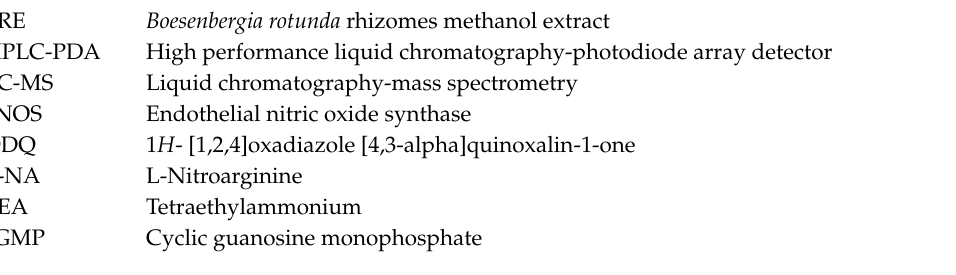
Figure S1. Comparison of HPLC profiles for three fractions derived from the vasoactive MeOH extract of Boesenbergia rotunda rhizomes (BRE), Figure S2. 1 H and 13 C NMR data of naringenin 5-methyl ether ( 1 ), Figure S3. 1 H and 13 C NMR data of alpinetin ( 2 ), Figure S4. 1 H and 13 C NMR data of pinocembrin ( 3 ), Figure S5. 1 H and 13 C NMR data of cardamonin ( 4 ), Figure S6. 1 H and 13 C NMR data of pinostrobin chalcone ( 5 ), Figure S7. 1 H and 13 C NMR data of pinostrobin ( 6 ), Figure S8. 1 H and 13 C NMR data of 4-hydroxypanduratin A ( 7 ), Figure S9. 1 H and 13 C NMR data of panduratin A ( 8